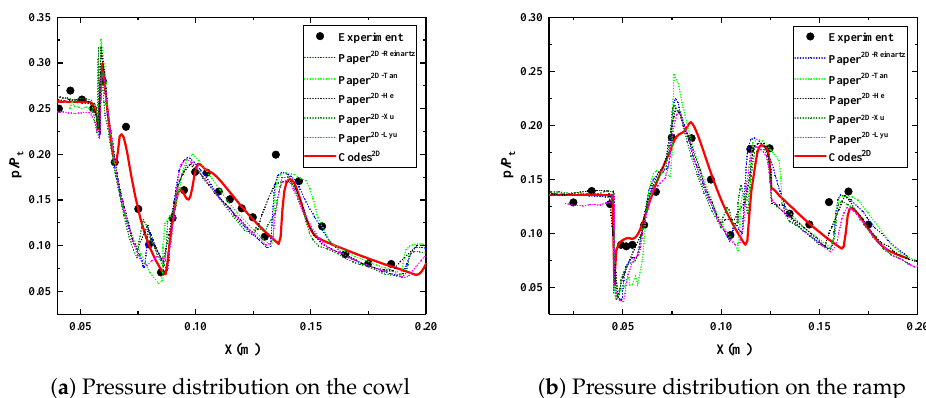
Figure 11. Comparison of other researchers’ results based on RANS.